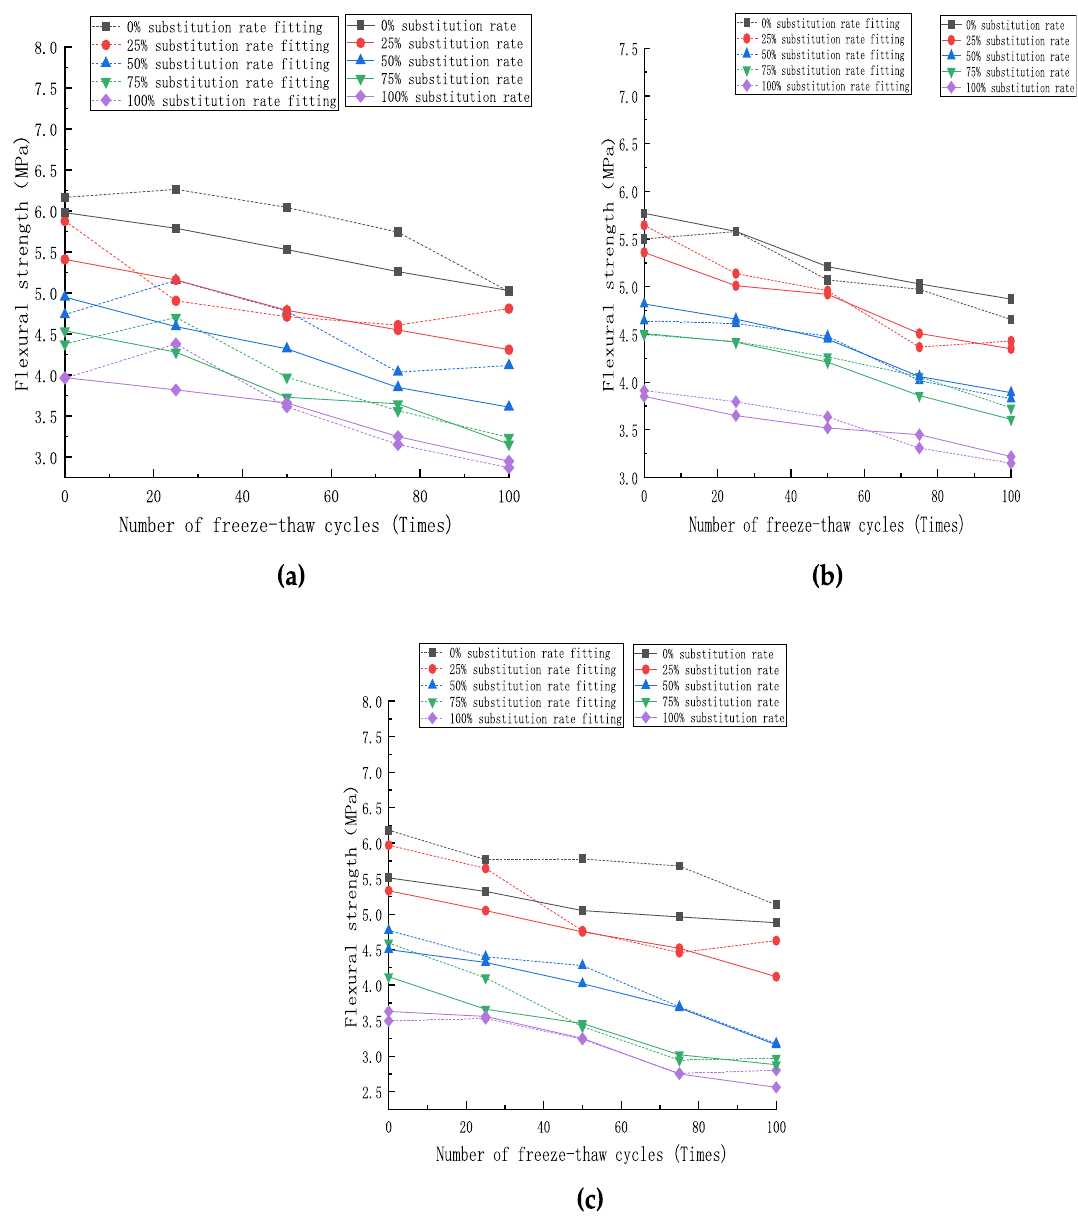
Figure 14. Flexural strength fitting curve: ( a ) steel fiber content 0%; ( b ) steel fiber content 1%; ( c ) steel fiber content